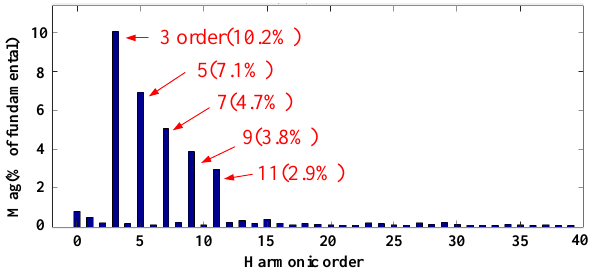
Figure 25. The THD analysis of harmonic load current. Table 7. The electric parameters of HCGIs system and the chips used in the controller.